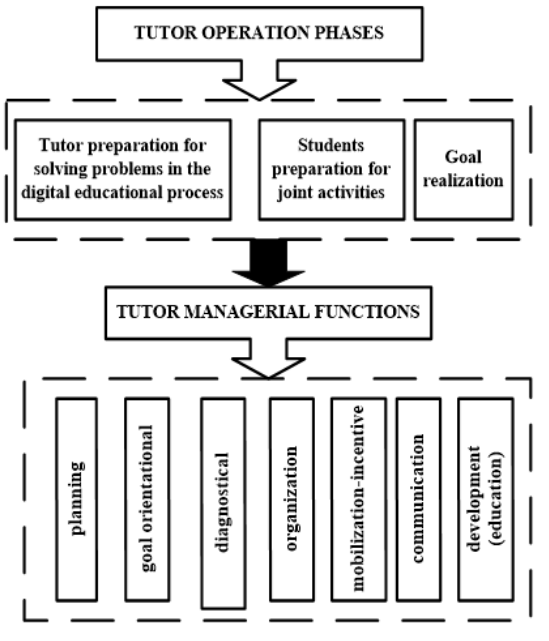
Figure 2. Tutor managerial